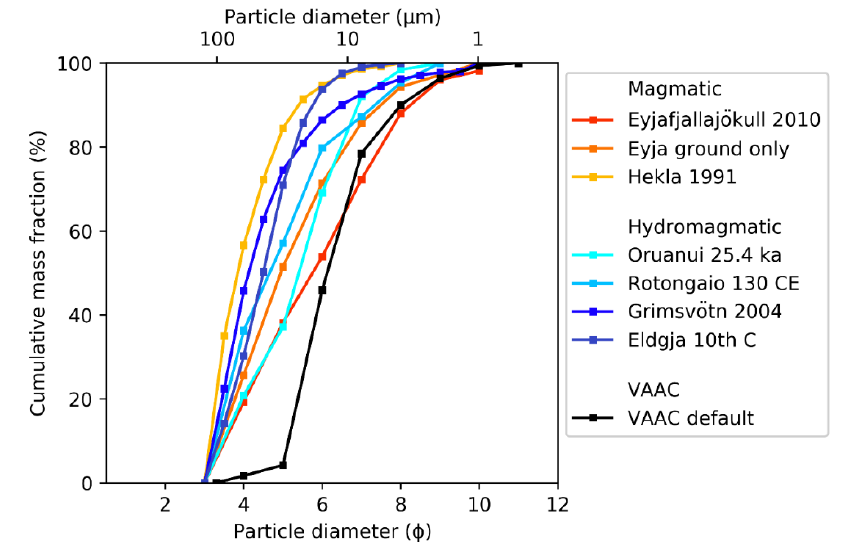
Figure 8. TGSDs, normalised to 125 µ m, selected for the Numerical Atmospheric Dispersion Modelling Environment (NAME) model runs.